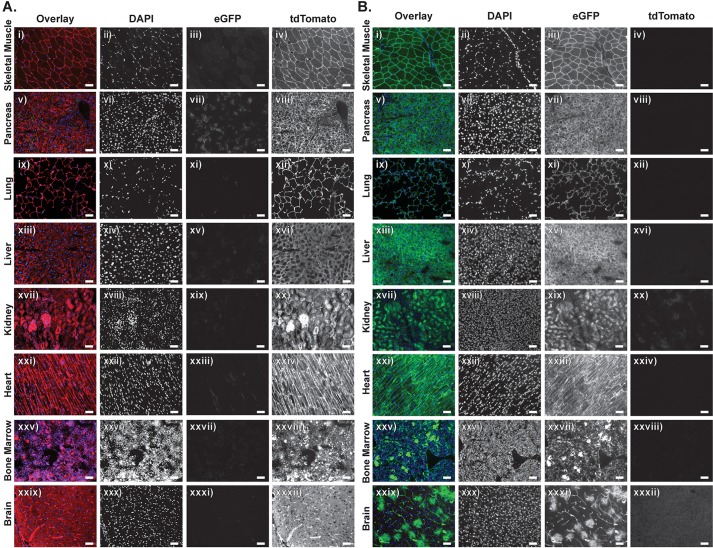
Characterization of tamoxifen-mediated Cre-ERT2 activity in Col1a1FRT-Cre-ER-T2-FRT mice. (A) Immunofluorescence of tissues from 6-week-old Col1a1FRT-Cre-ER-T2-FRT; Rosa26mTmG/+ mice (n=2) without tamoxifen treatment show widespread tdTomato with tissue-specific minimal to no eGFP expression, with the pancreas showing the most Cre-ERT2 leakiness (Avii). (B) Immunofluorescence of tissues collected 30 days after one dose of intraperitoneal tamoxifen in 6-month-old mice (n=3) show extensive Cre-mediated expression of eGFP and tissue-specific tdTomato degradation. Note that the brain (Bxxxii) has the highest amount of tdTomato retention as well as areas of low/no eGFP expression. Scale bars: 50 µm.